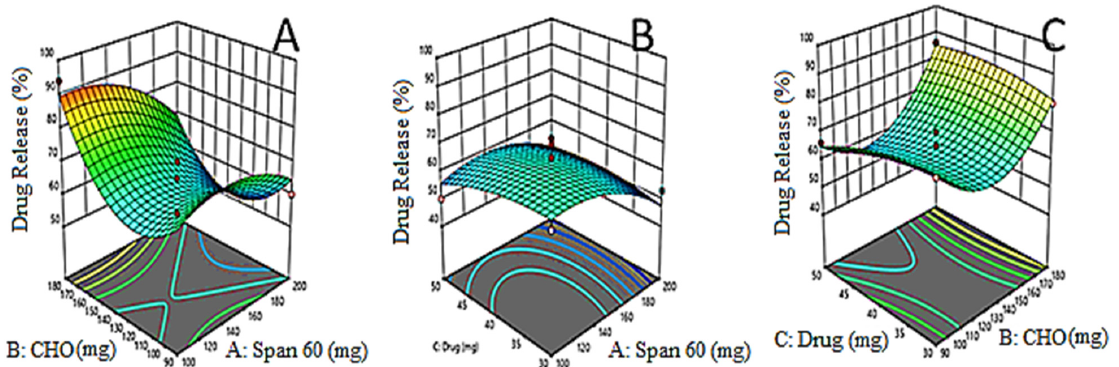
Figure 3. ( A – C ): 3D ‐ Response surface plots demonstrating the influence of independent variables i.e., amount of span 60 (X 1 ), amount of cholesterol (X 2 ) and amount of drug (X 3 ) on drug release.